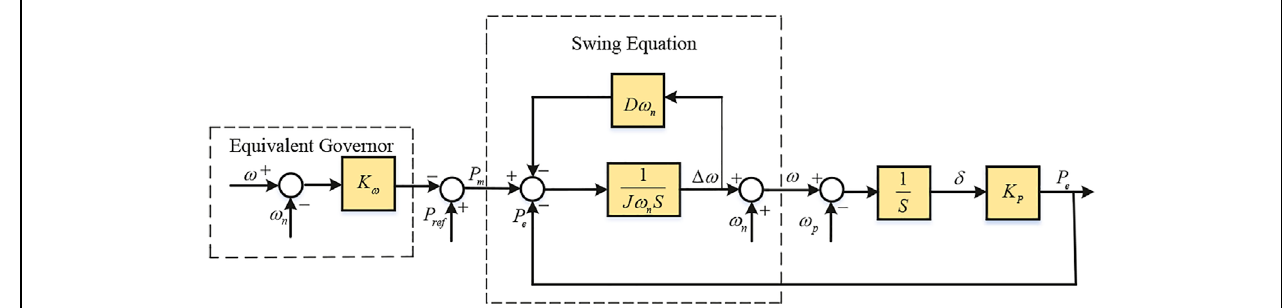
FIGURE 2 | Control modules of active power control module.